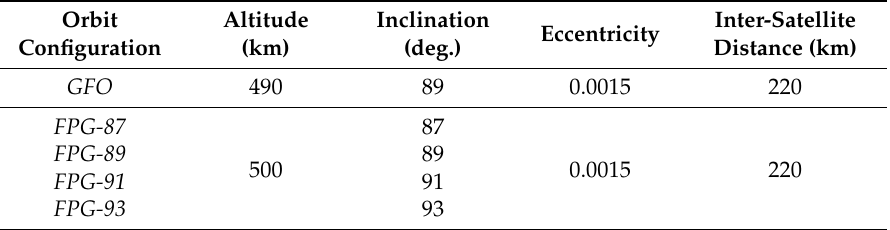
Table 1. Initial orbit configurations of GFO and FPG for simulation